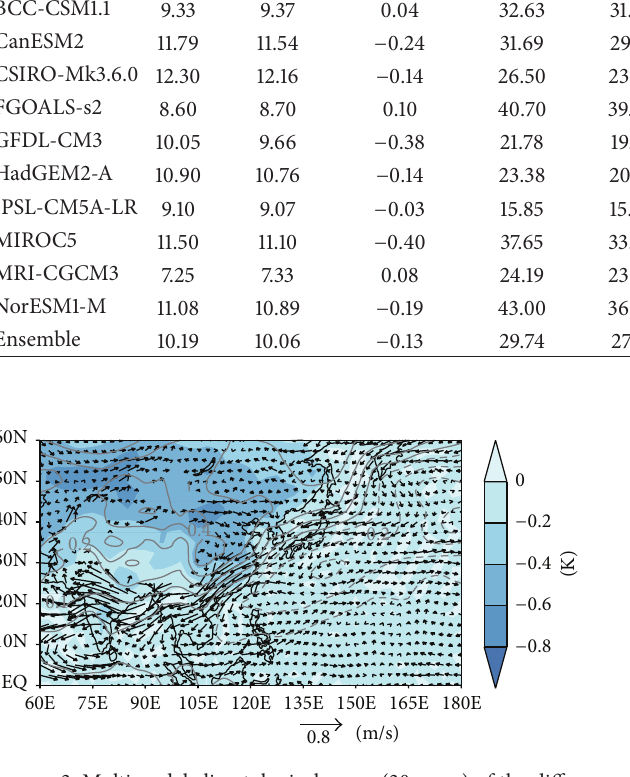
Figure 3: Multimodel climatological mean (30 years) of the differ- ence (aerosol run minus CTL run) of summer surface temperature (shading; units: K), SLP (contours; units: hPa), and 850 hPa winds (vectors; units: